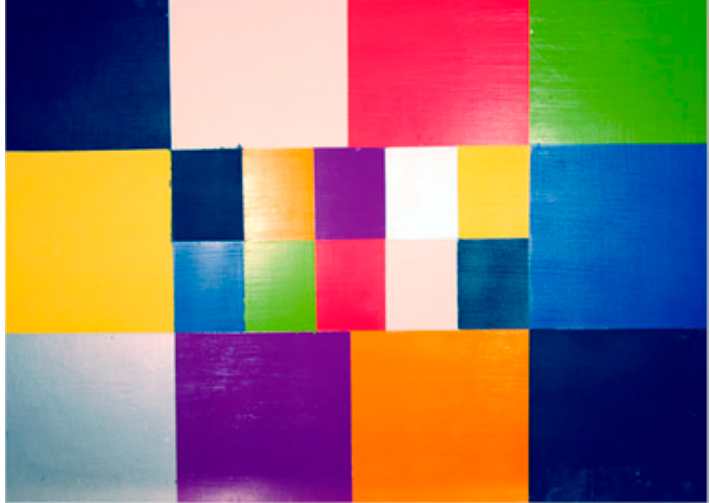
Figure 7. The sample analyzed: Front panel.